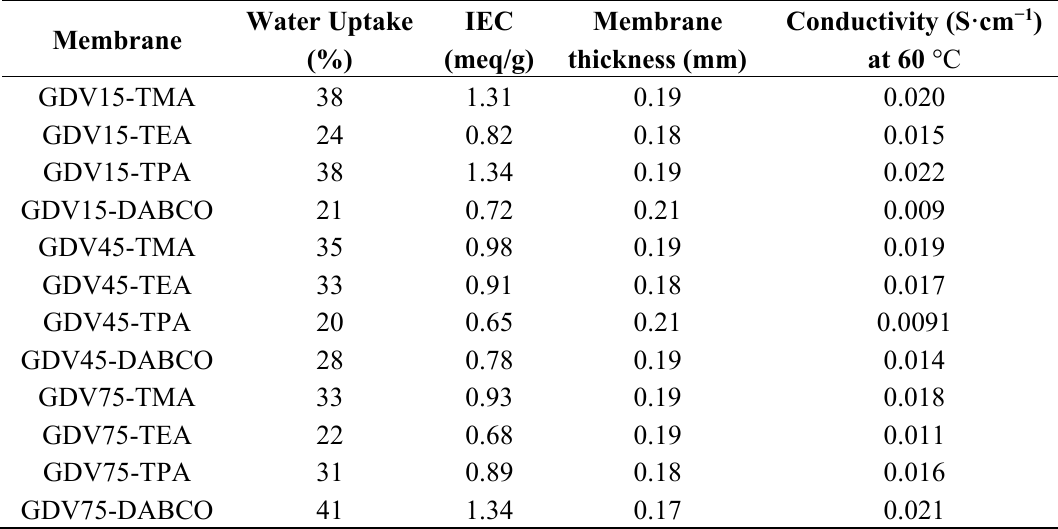
Table 3. Properties of the anion exchange membranes. Ion conductivity of non-woven PET with pure water at 60 °C was 1.52 × 10 − 10